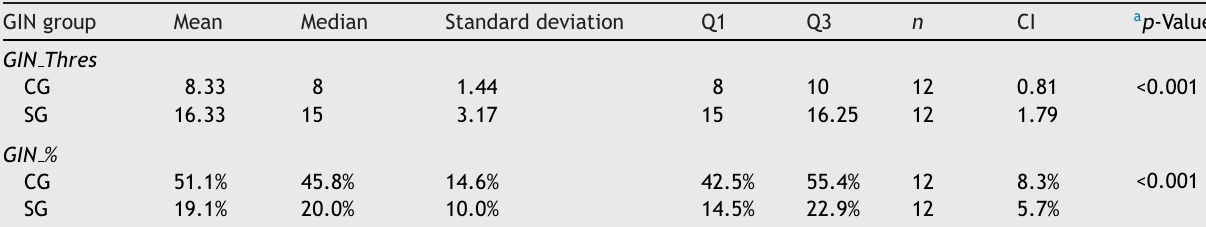
Descriptive statistics of the Gaps-in-Noise (GIN) test performance according to the group.